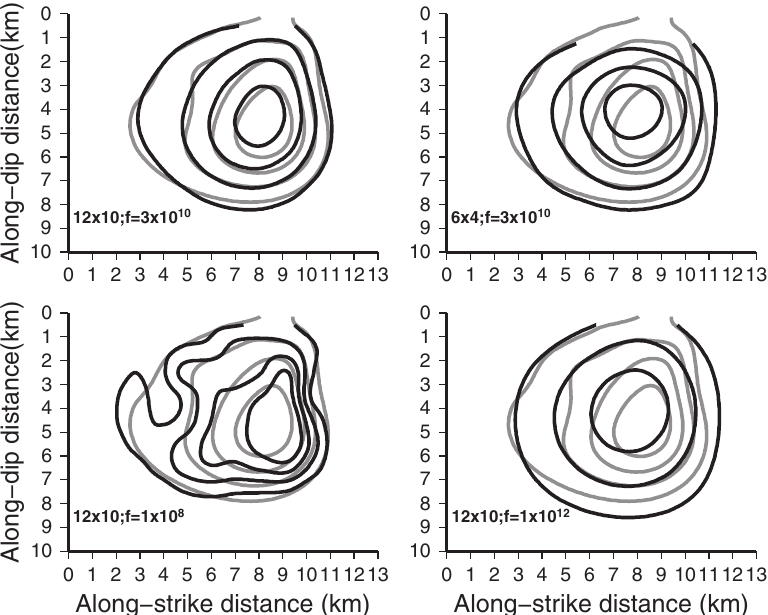
Fig. 11. Gray contours, all plots: best fit 40 × 32-subfault slip distribution (f = 3 × 10 10 ). Black contours: top left, best fit 12 × 10-subfault slip distribution ( f = 3 × 10 10 ); top right, best fit 6 × 4-subfault slip distribution ( f = 3 × 10 10 ); bottom left, best fit 12 × 10-subfault slip distribution ( f =108); bottom right, best fit 12 × 10-subfault slip distribution ( f = 3 × 10 12